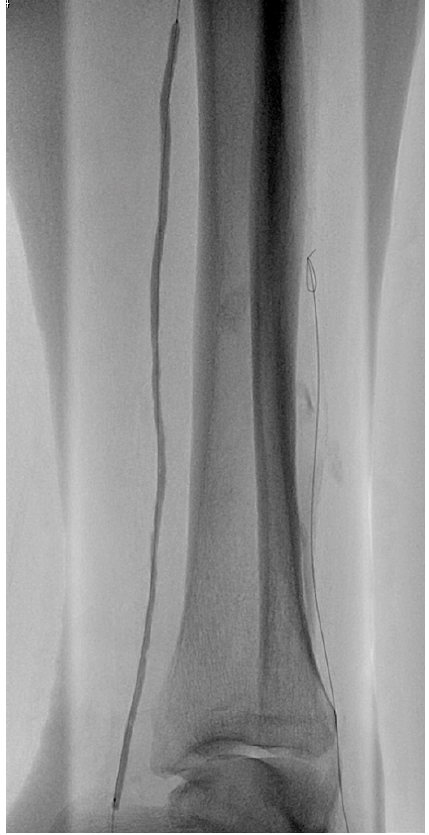
Figure 4. Angioplasty of posterior tibial artery after pedal plantar loop technique.